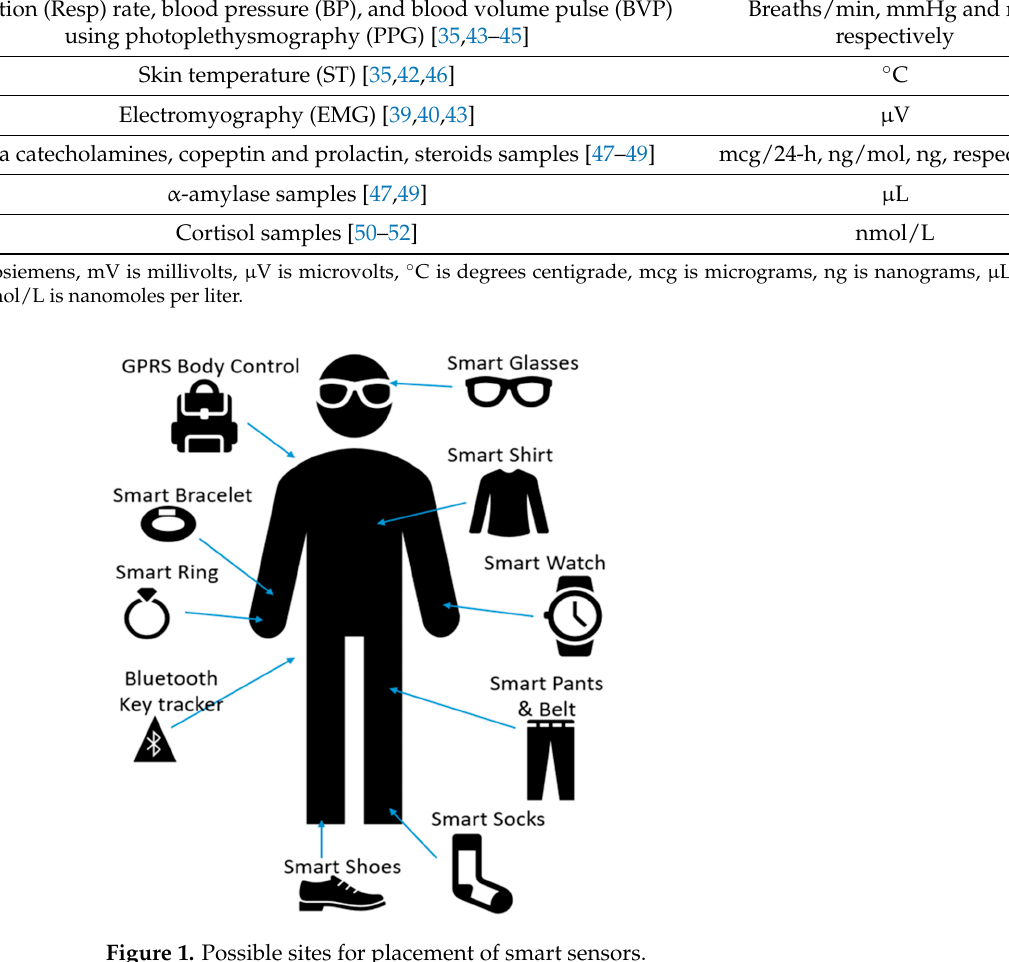
Figure 1. Possible sites for placement of smart sensors.